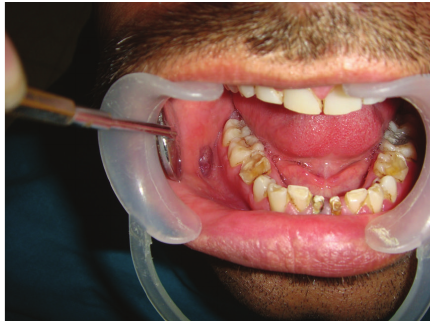
Figure 1: Purple lesion of buccal mucosa.